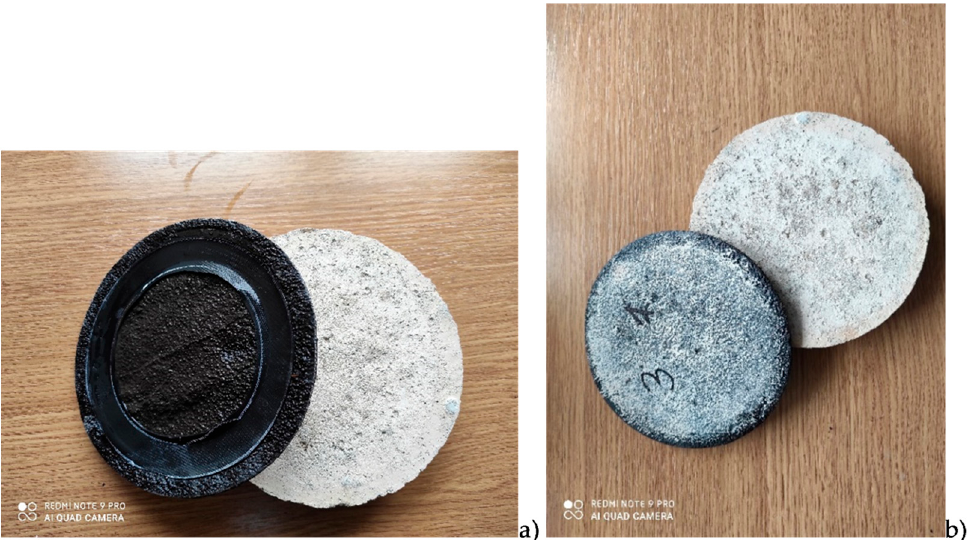
Figure 2. Samples after the waterproofness tests: ( a ) top side of the sample after removal from the concrete substrate, ( b ) bottom side of the sample. Next to it, there is a concrete substrate.